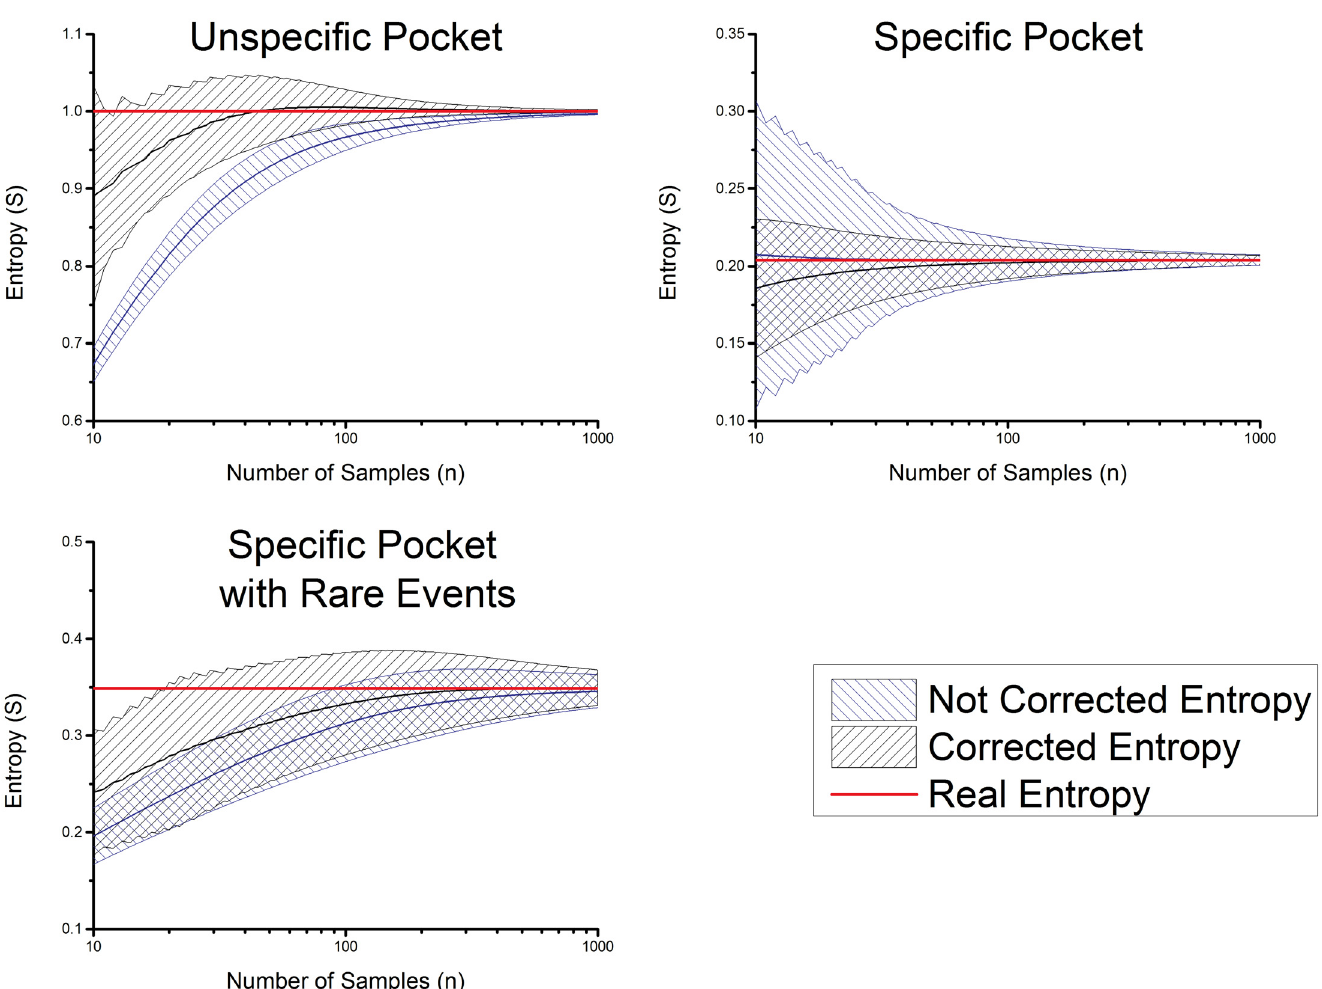
Fig 2. Trend of the measured entropy and estimated entropy with the number of known substrates. The cases of a totally unspecific pocket (upper left), an unspecific pocket (upper right) and an unspecific pocket with rare events (lower left) are shown. The filled areas correspond to the possible measured values including the standard